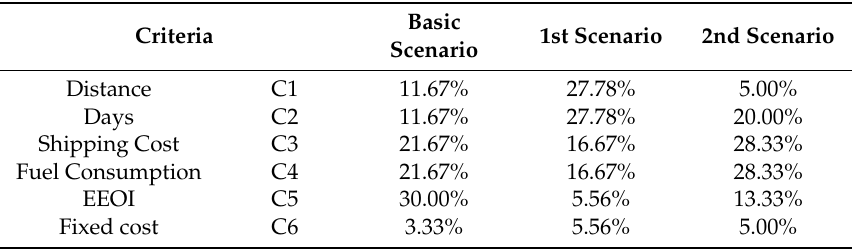
Table 2. Weights matrix for all the